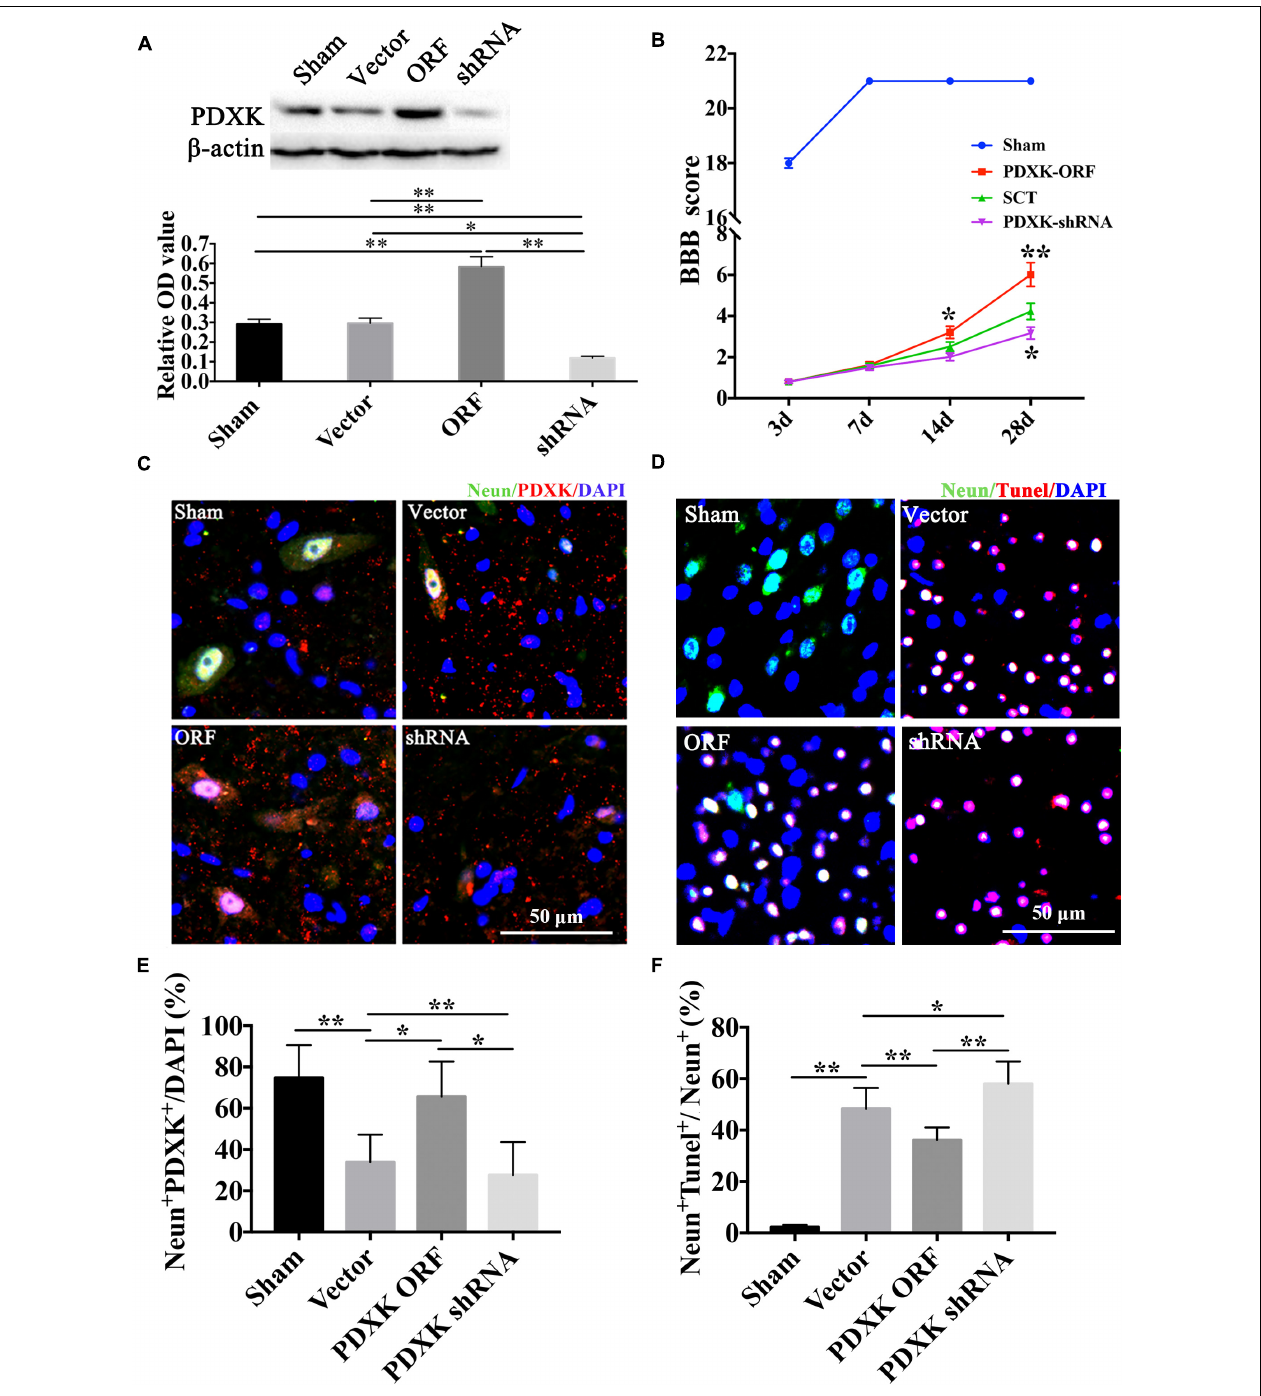
FIGURE 3 | BBB score, NeuN immunofluorescent staining, and TUNEL assay of the cerebral cortex motor area in Lentivirus-treated rats. (A) The expression of PDXK following PDXK ORF and PDXK shRNA transfection in the cortex of SCT rats by Western blot. (B) The locomotor function was assessed by BBB score. (C) Pictures of neurons collected by double immunofluorescent staining of NeuN and PDXK in the cerebral cortex motor area. (D) Quantitative column diagram of number of NeuN and PDXK double-positive cells was obtained by Leica AF6000 system. Scale bar = 50 µ m. * P < 0.05; ** P < 0.01. (E) Pictures of apoptotic cells measured by NeuN immunofluorescent staining and TUNEL staining, presented by NeuN + Tunel + /NeuN + (%) in the cerebral cortex motor by Leica AF6000 system. (F) Quantitative histogram of neuronal apoptosis. Scale bar = 50 µ m. * P < 0.05; ** P < 0.01. Data were exhibited as mean ± SD. BBB, Basso, Beattie, and Bresnehan; TUNEL, terminal deoxyribonucleotidyl transferase-mediated dUTP-digoxigenin nick-end labeling; PDXK, pyridoxal kinase; SCT, spinal cord transection; DAPI, 4, 6-diamidino-2-phenylindole.